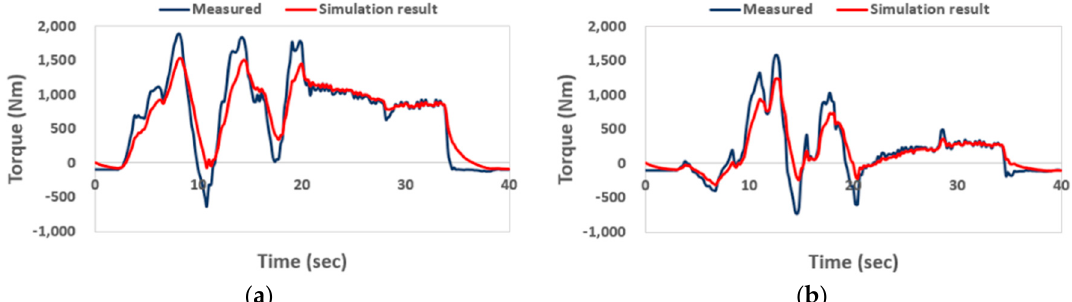
Figure 8. Comparison of averaged tractor axle torque of ( a ) left and ( b ) right sides for measured and simulated results at ground speed of 10 km/h in on-road conditions.